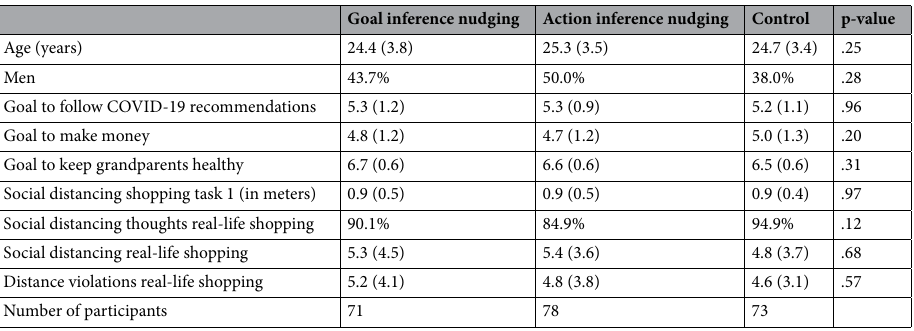
Table 3. Descriptives and randomization Check for Study 2 . The table reports the average and standard deviations (in parentheses) of participant demographic variables and responses to questions about goals and social distancing behavior in each condition of Study 2, the p-value of the effect of condition in an ANOVA for each variable, and the number of participants in each condition. For gender, the p-value is for a Wald test. If a given p-value is greater than .05, it means the corresponding test does not allow us to reject the null hypothesis that all conditions have the same value for the corresponding variable.